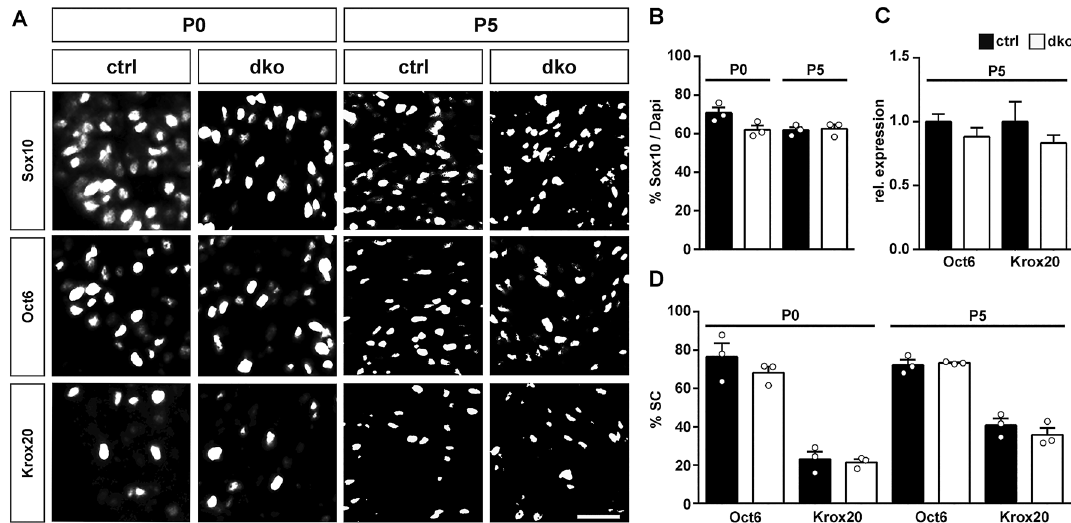
Figure 4. Expression of stage-specific transcription factors in sciatic nerves of dko mice at early postnatal stages. ( A ) Representative stainings on sciatic nerve sections of control and dko mice at P0 and P5 with antibodies directed against Sox10, Oct6 and Krox20. Scale bar, 25 µm. ( B ) Quantification of the percentage of Schwann cells among all cells in the sciatic nerve of control (black bars) and dko (white bars) mice at P0 and P5 (n = 3). ( C ) Quantification of the amount of Oct6 and Krox20 transcripts by qRT-PCR in sciatic nerves of control (black bars) and dko (white bars) mice at P5 (n = 6). Transcript levels in controls were set to 1 for each gene, those for dko mice expressed relative to it (± SEM). ( D ) Quantification of the percentage of Schwann cells that express Oct6 and Krox20 in the sciatic nerve of control and dko mice at P0 and P5 (n = 3). Numbers were not significantly different as determined by unpaired, two-tailed Student’s t-test. For p-, t- and df-values, see Supplementary Fig. S3. Bars represent mean values ± SEM.